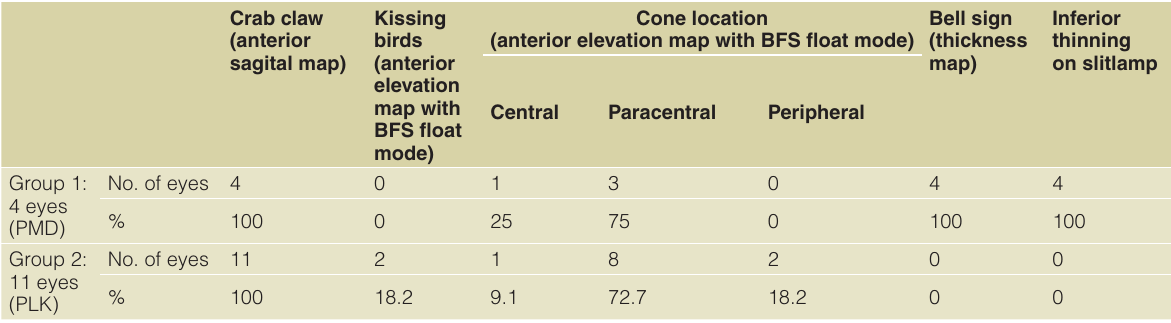
Table 1. Clinical and topographical findings in groups 1 and